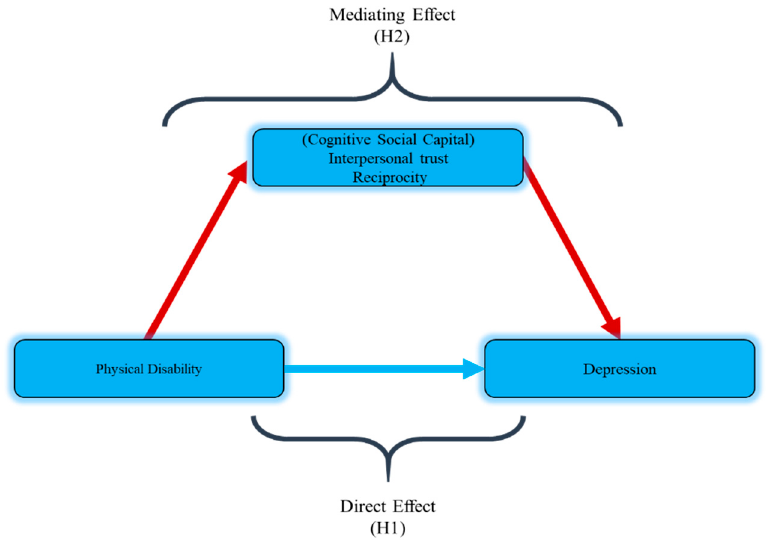
Figure 1. Hypothetical model.